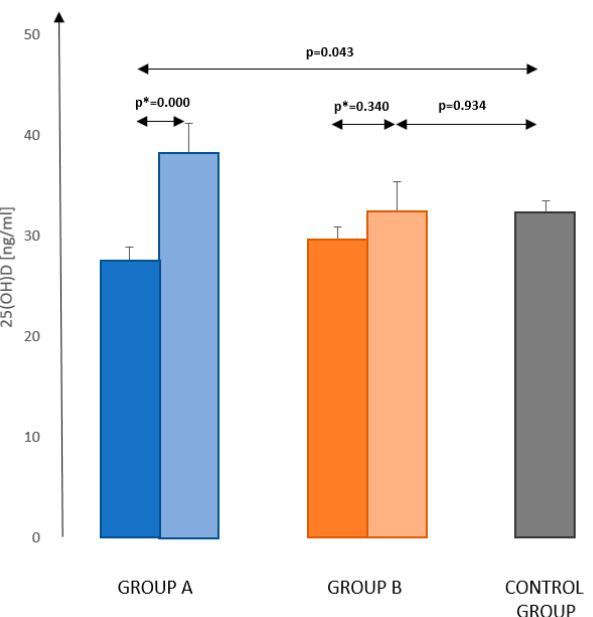
Figure 1. Mean concentrations of 25(OH)D ( ± SD—error bars) in the healthy control group and the groups of women treated for breast cancer. Values before inclusion into study—dark (left) bars in the pair and during second testing half year later—pale bars (right) in the pair. Group A—women treated for breast cancer tested the first time in winter; Group B—women treated for breast cancer tested the first time in summer. Comparison of the results in the control group (obtained in winter) with the results of studied groups in winter. p *—paired t -test; p — t